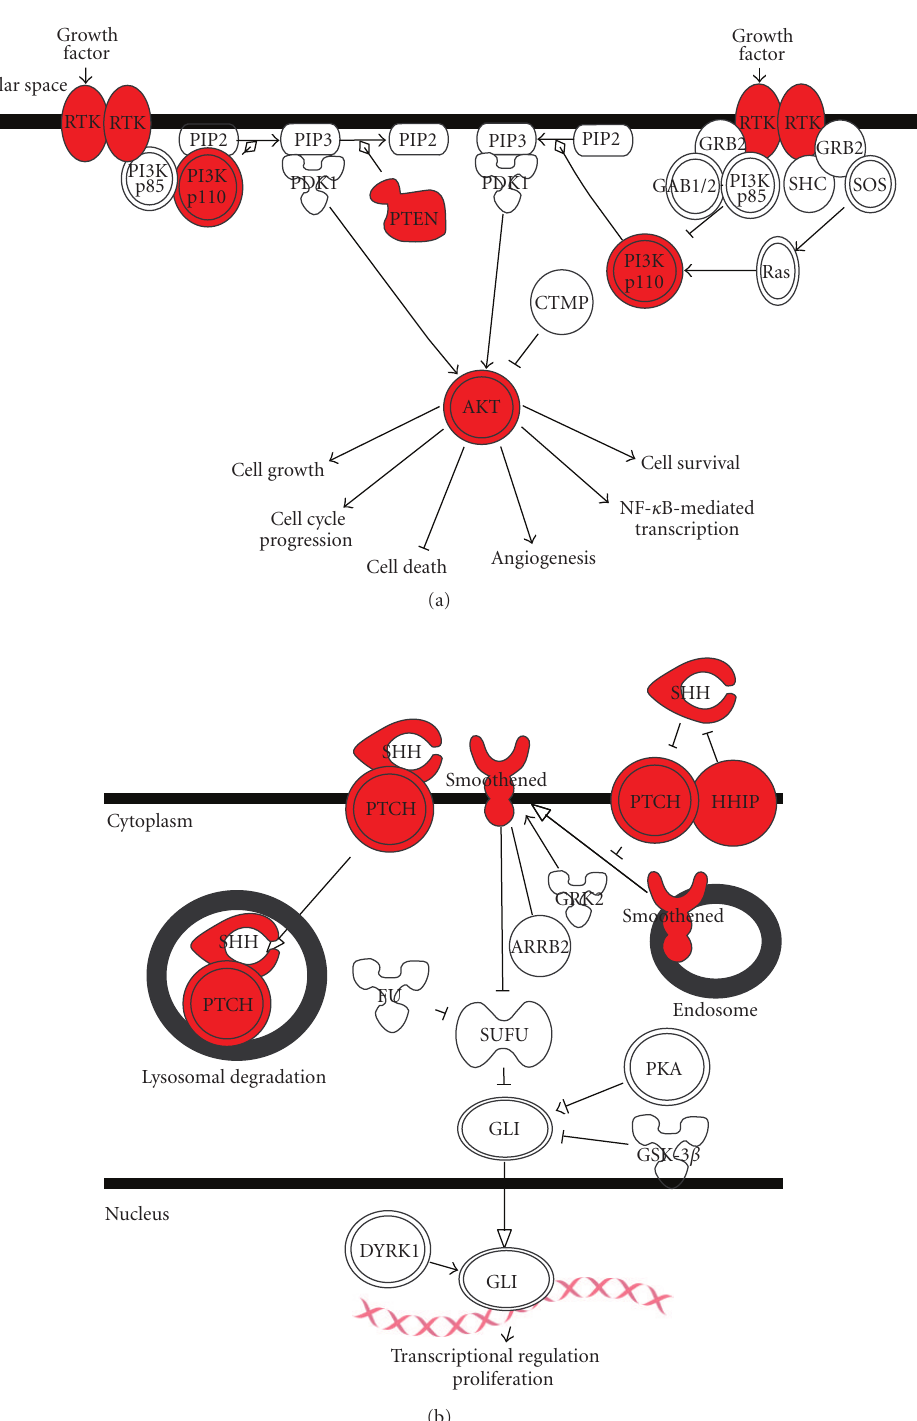
Figure 6: Major pathways a ff ected in NMSC. (a) SqCC undergoes frequent alterations to the PI3K/AKT signaling pathway. (b) BCC undergoes frequent alterations to the sonic hedgehog pathway. Various pathway components a ff ected are highlighted in